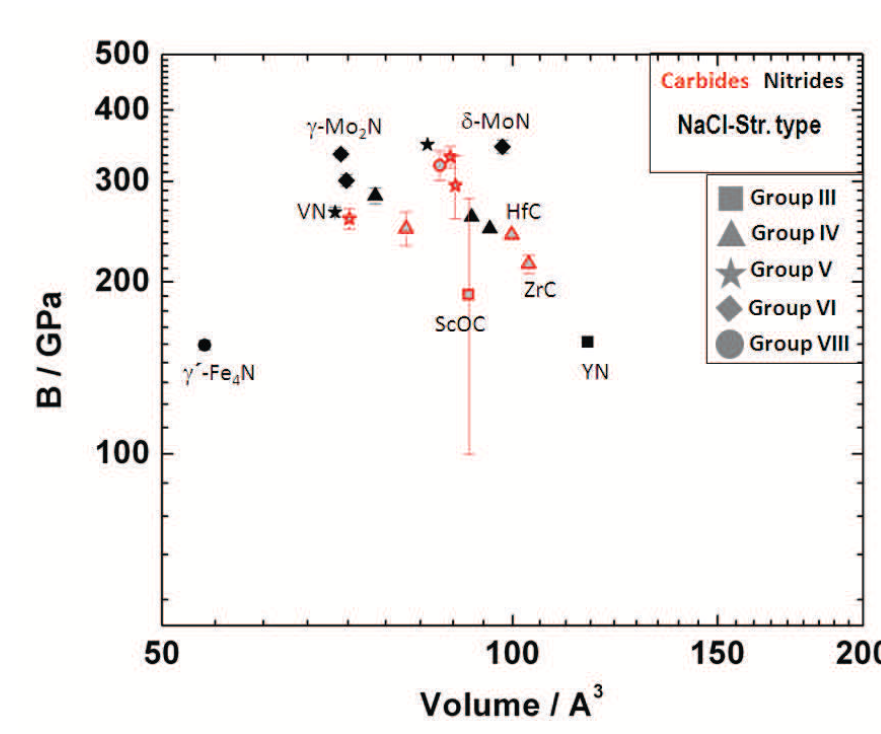
Figure 22. Plot of the unit cell volume of NaCl-type binary transition metal carbides and nitrides versus bulk